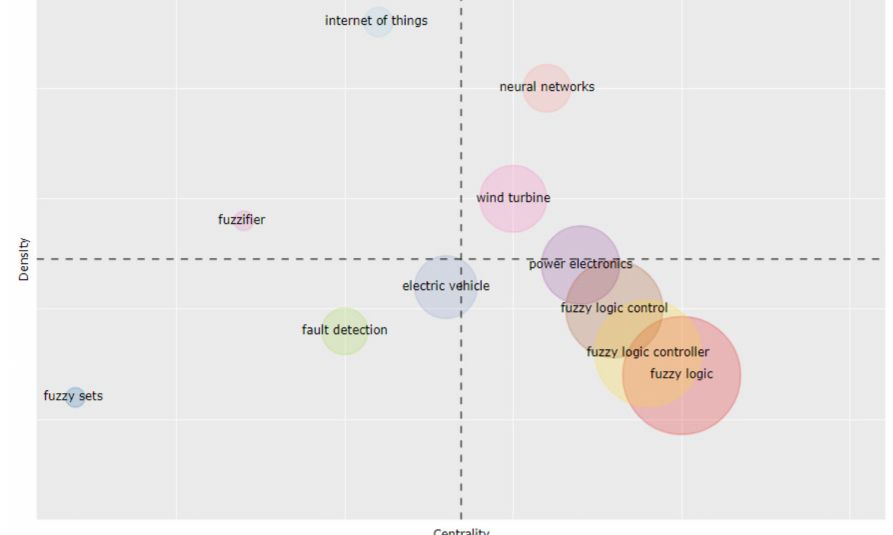
Figure 19. Thematic map based on the authors’ keywords.